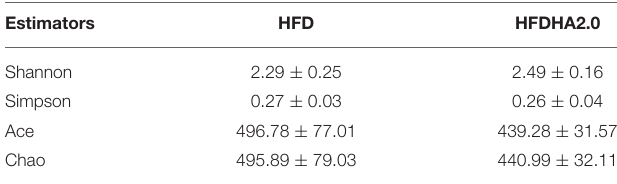
TABLE 4 | Diversity index of gut bacteria of zebrafish fed with HFD or HFDHA2.0 for 4 weeks. Estimators HFD HFDHA2.0 Shannon